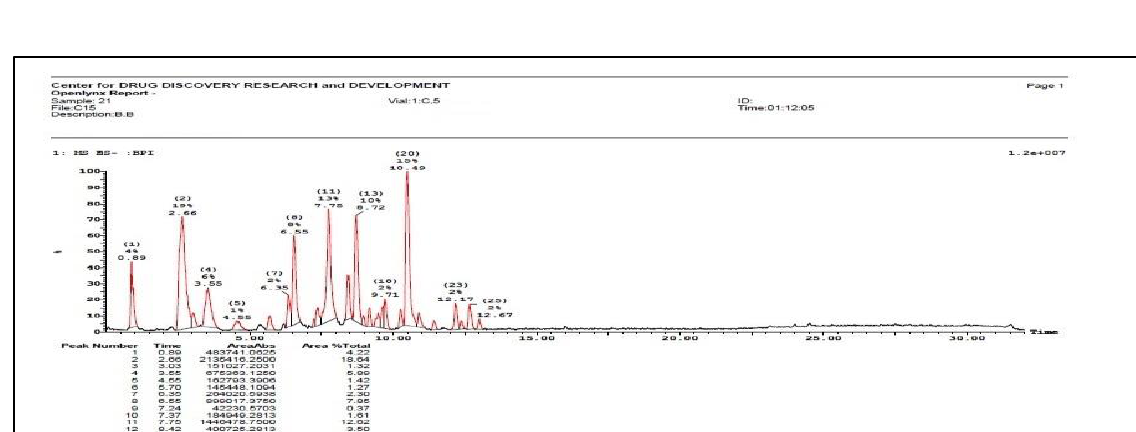
Figure 11. UPLC chromatogram of B.B